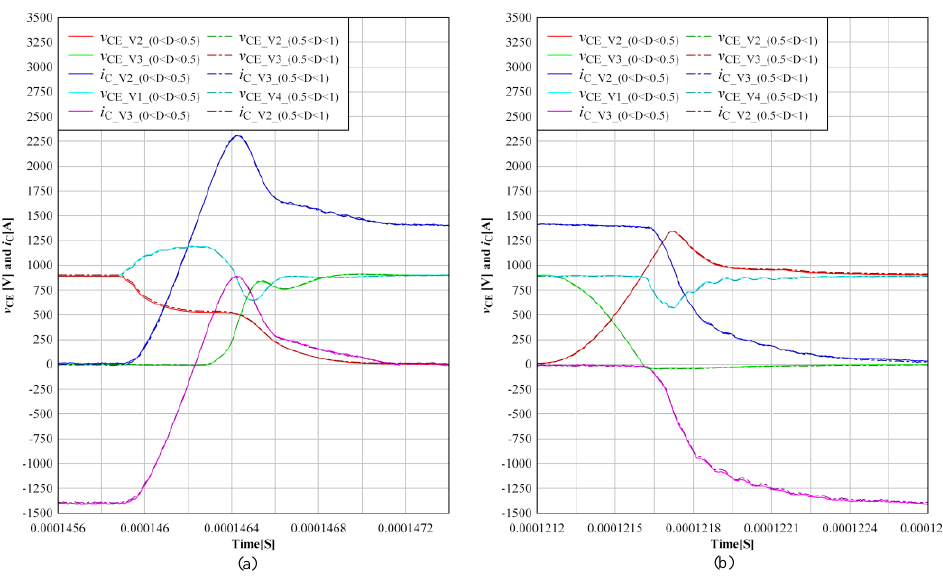
Figure 20. Influence of the current paths of inner commutation loop in buck mode. ( a ) Detail waveforms during IGBT turn-on. ( b ) Detail waveforms during IGBT turn-off.